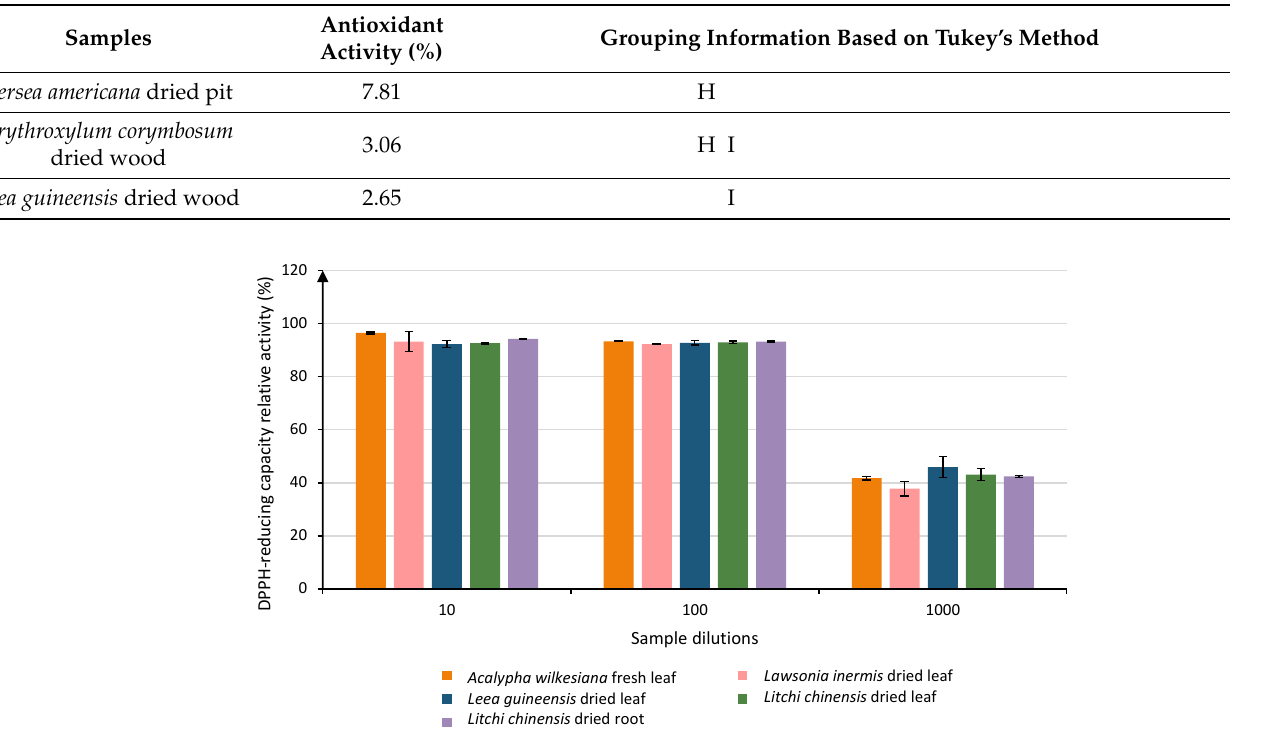
Figure 2. Evolution of the relative DPPH-reducing capacity of the five most efficient samples at 3 different dilutions (10 1 , 10 2 and 10 3 ). Each column represents the mean ± SD ( n = 3) per sample.